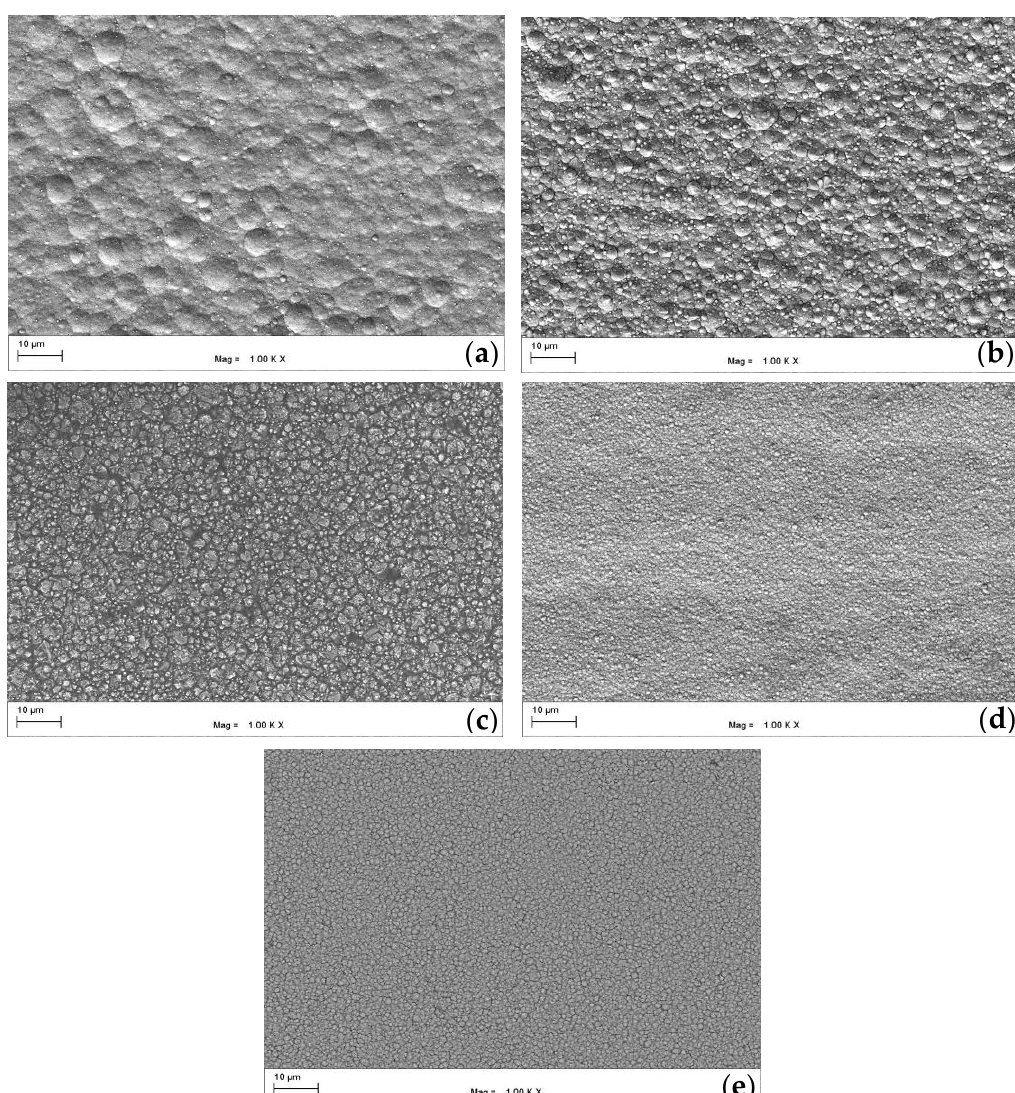
Figure 3. FESEM photographs of coatings prepared under different conditions: ( a ) sample-I; ( b ) sample-II; ( c ) sample-III; ( d ) sample-IV; ( e ) sample-V.